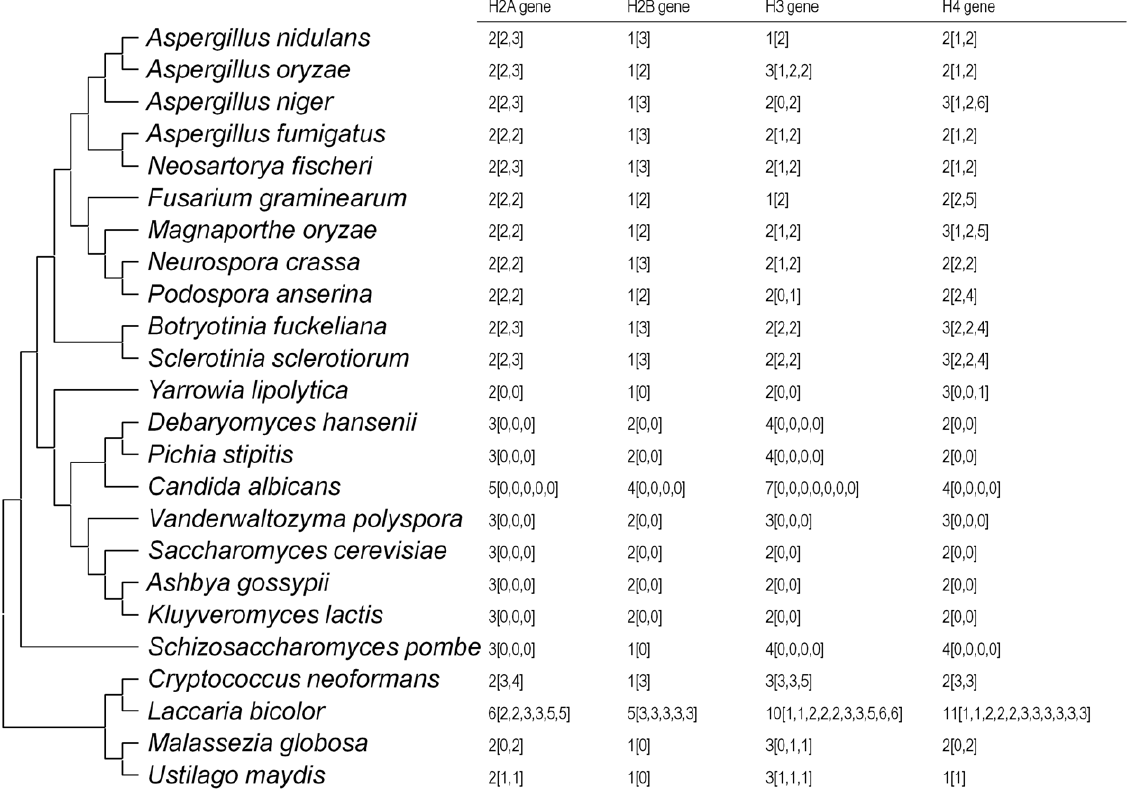
Figure 2. Number of core histone genes and introns in the gene. The numbers in parentheses indicate the number of introns within each gene. The phylogenetic topology is based on Fig. 1.